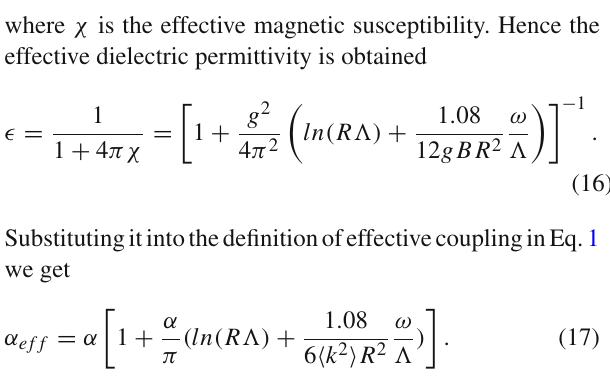
with traditional parameters (cid:7) = 0 . 65 GeV, m = 0 . 005